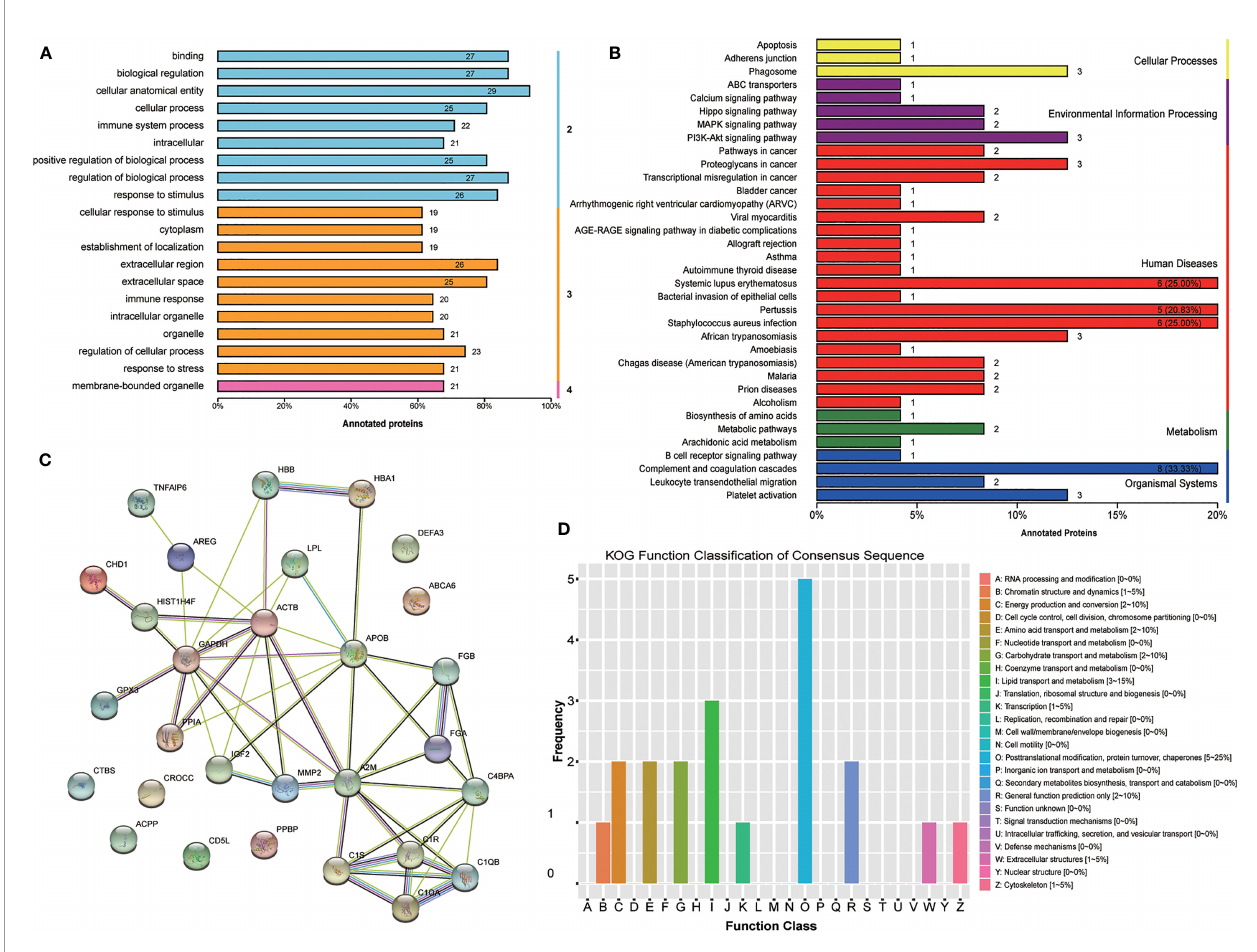
FIGURE 3 | Bioinformatics analysis of the set of follicular fl uid protein biomarker candidates for mature oocytes. (A) Gene Ontology (GO) level classi fi cation; (B) Kyoto Encyclopedia of Genes and Genomes (KEGG) enrichment classi fi cation; (C) STRING analysis; (D) Clusters of Protein Homology (KOG) function classi fi